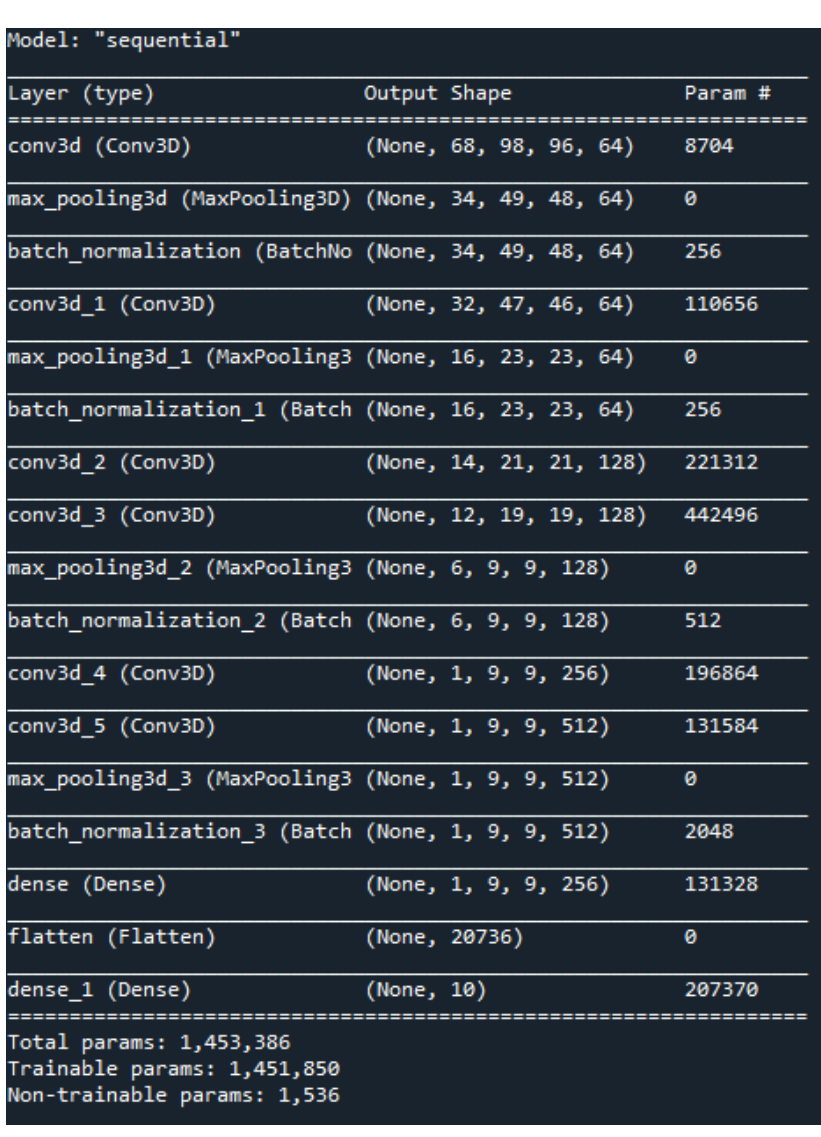
Figure 6. The description of the layers of the proposed